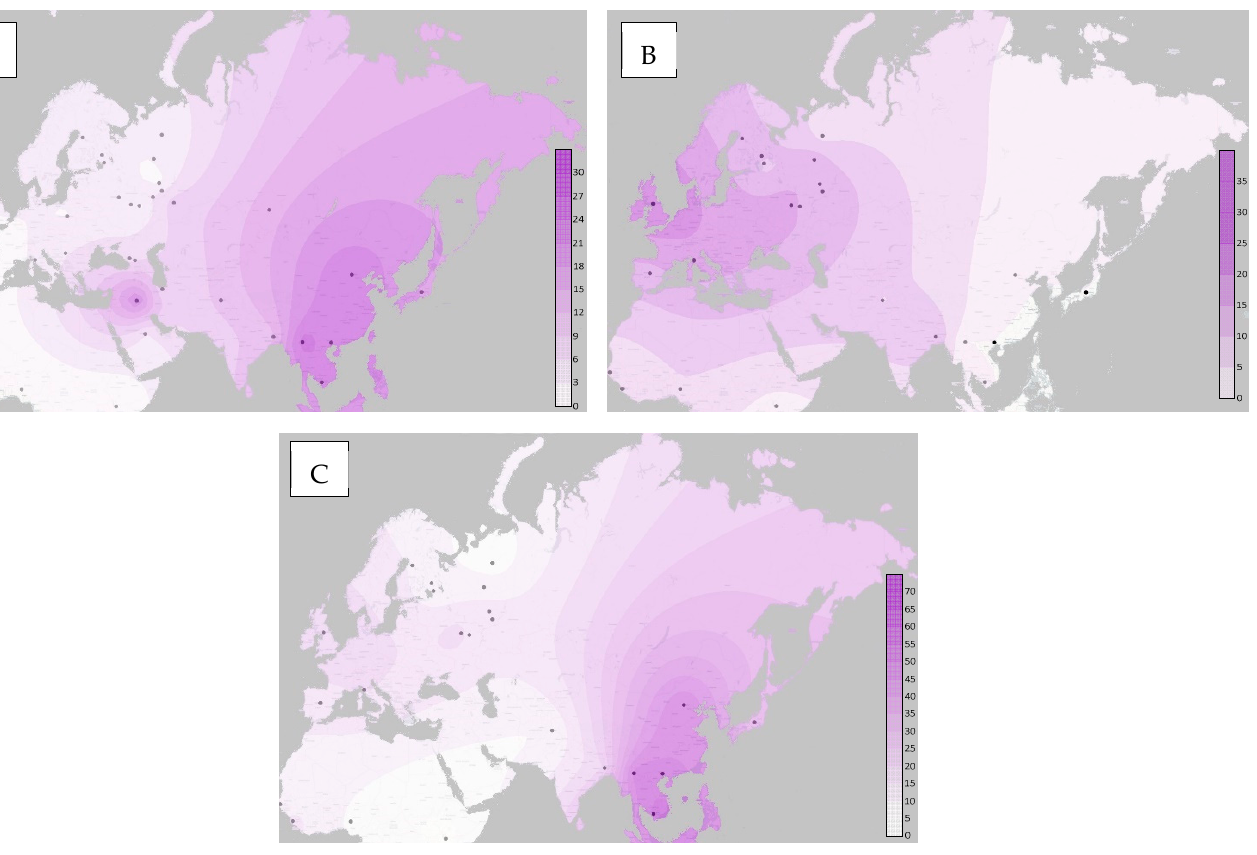
Figure 2. Distribution maps of minor alleles ( A ) rs1048943, ( B ) rs3892097, ( C ) rs1065852.